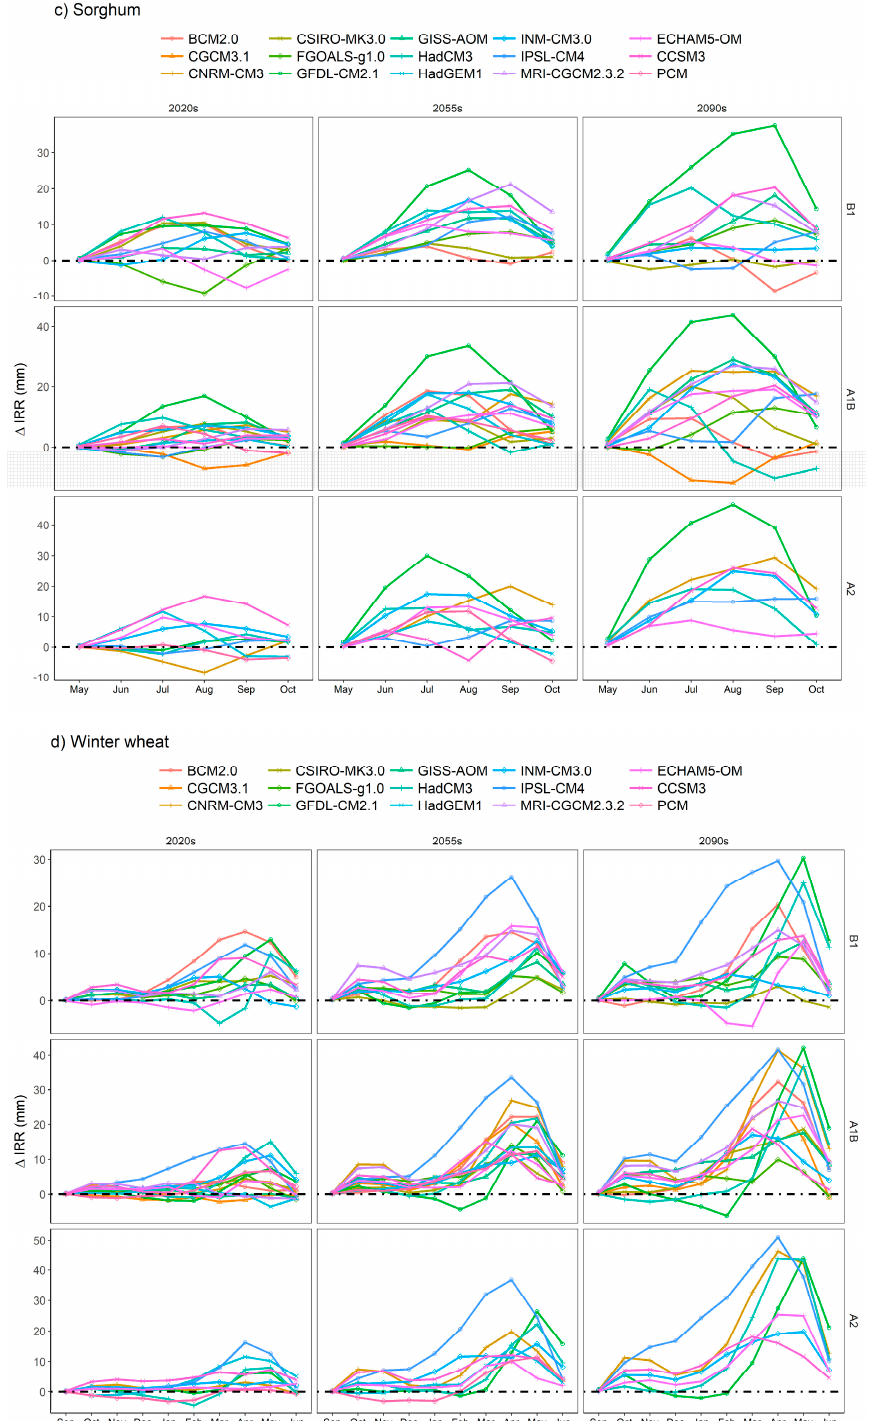
Figure 5. Uncertainties between GCMs in predicting monthly irrigation requirements of corn ( a ); cotton ( b ); sorghum ( c ); and winter wheat ( d ) for three future periods and under three greenhouse gas emission scenarios.